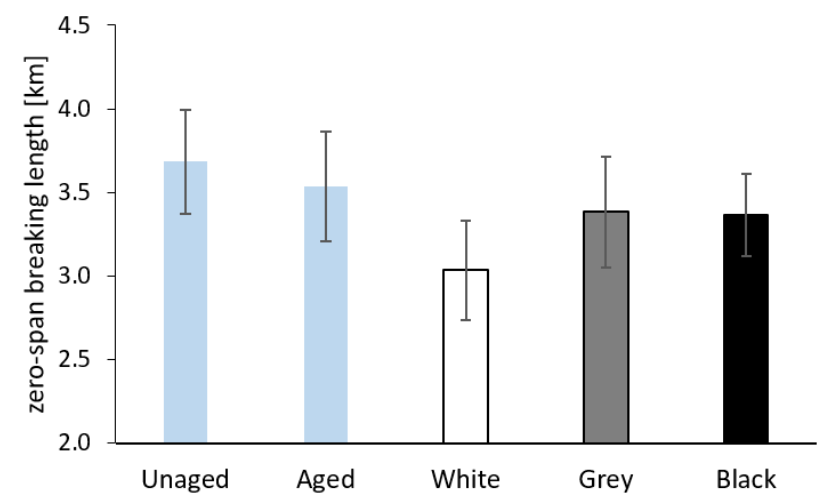
Figure 12. The zero-span breaking length of Whatman Grade 1 paper before aging (Unaged), after artificial aging without contact with PE foam (Aged), and in contact with the tested PE foams.